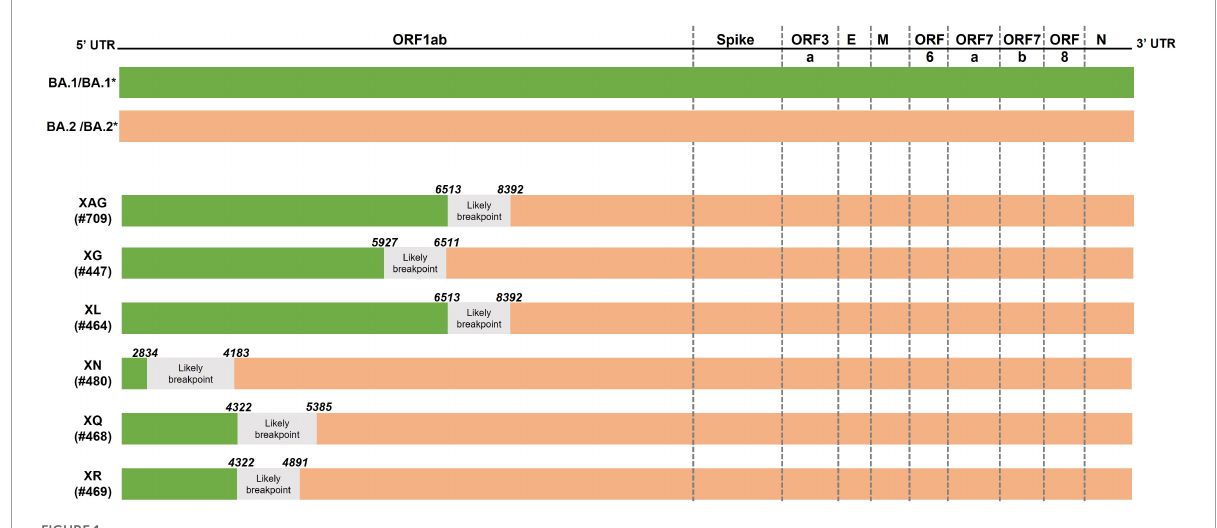
and between Omicron variant sublineages such as BA.1 and BA.2